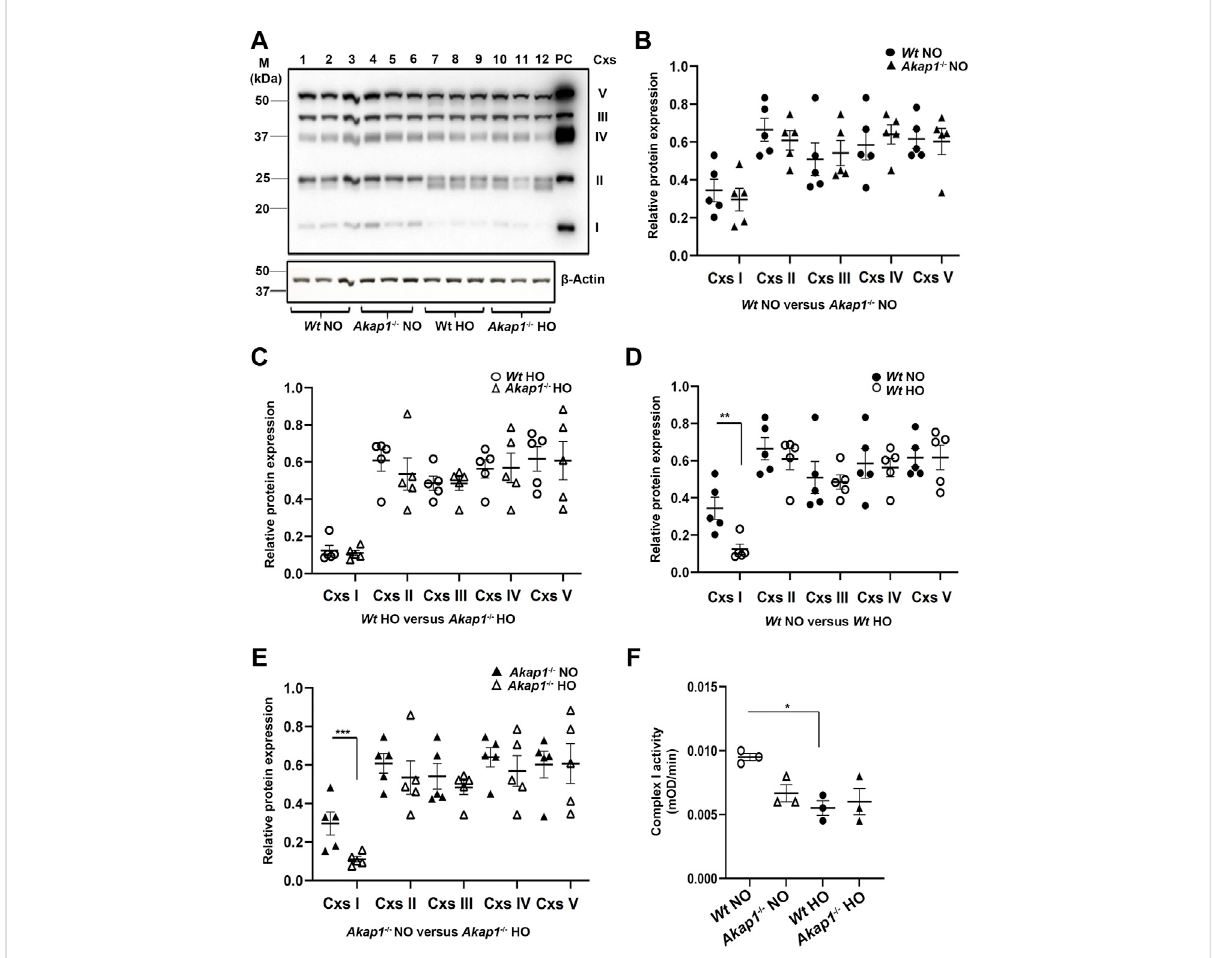
FIGURE 3 AKAP1losscausesOXPHOSandComplexIdysfunctioninhyperoxia. (A) WesternblotanalysesforOXPHOSComplexesinthelunglysatesof Wt and Akap1 − / − exposed to normoxia or hyperoxia. A representative image is shown. PC: Positive control (Rat heart mitochondrial lysate). Data normalized to β -Actin (loading control). (B) Quantitation of Complexes I to V in Wt normoxia vs. Akap1 − / − normoxia. (C) Quantitation of Complexes I toVin Wt hyperoxiavs. Akap1 − / − hyperoxia. (D) QuantitationofComplexesItoVin Wt normoxiavs. Wt hyperoxia.** p < 0.01versus W thyperoxia controls (E) Quantitation of Complexes I to V in Akap1 − / − normoxia vs. Akap1 − / − hyperoxia. *** p < 0.001 versus Akap1 − / − hyperoxia. Relative